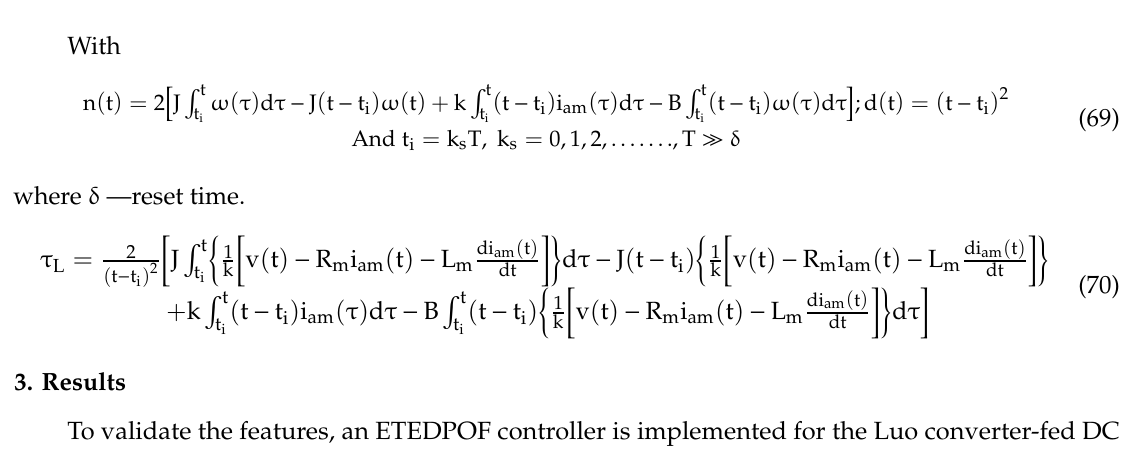
Figure 5. Hardware setup for the Luo converter-fed DC motor. The Luo converter and controller are used for controlling the DC motor speed under the armature control method. The specifications for the system of interest and the base values are given in Table 1. Hardware waveforms are stored in comma separated value (CSV) format and then these values are exported to MATLAB along with the simulated values for the comparison of both hardware and simulation results.